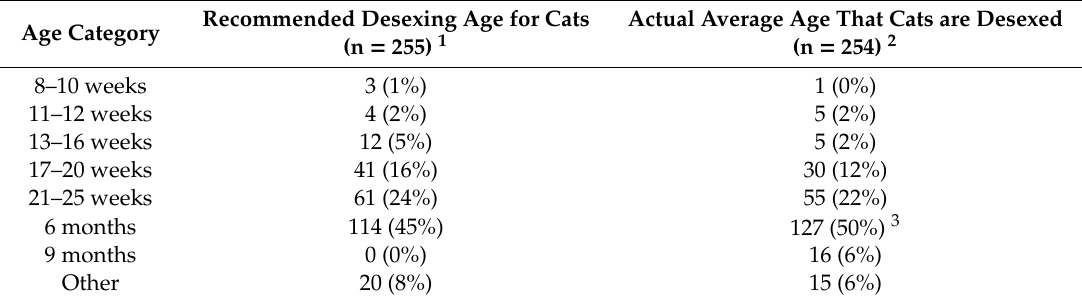
Table 1. Ages that respondents’ recommended cats be desexed and actual average ages that cats are desexed in Queensland veterinary practices.